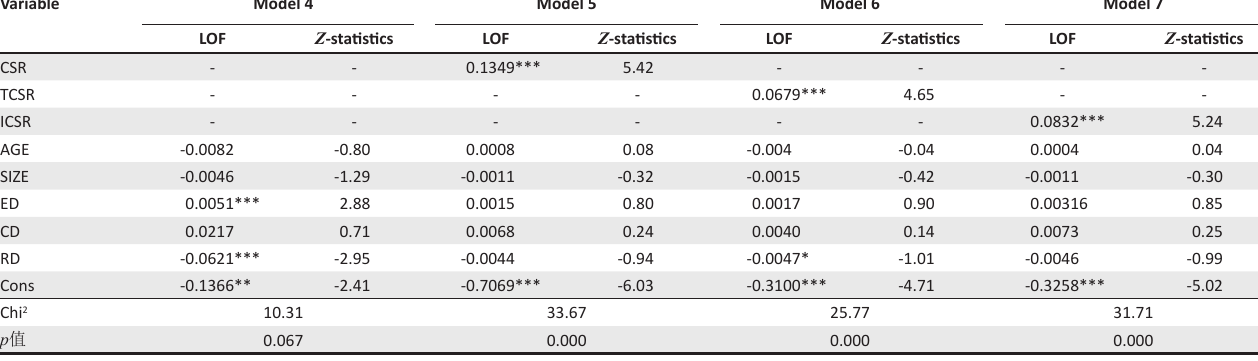
TABLE 3: The impact of corporate social responsibility and its components on corporate reputation of the parent